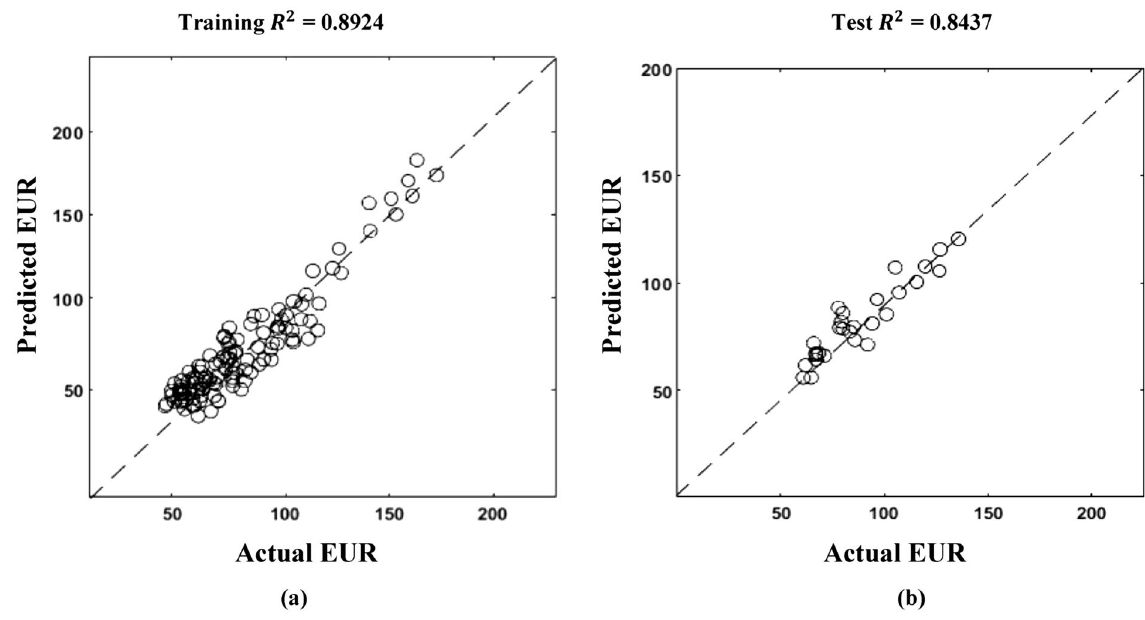
Figure 20. SEDM decline model EUR